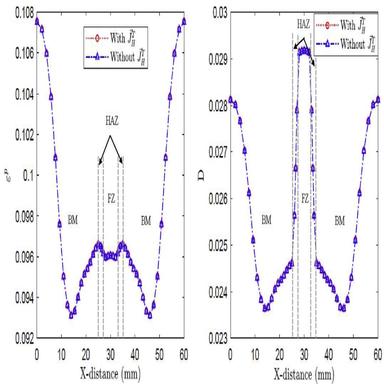
Equivalent plastic strain p (to the left) and damage variable D (to the right): comparison between the mechanical model and the M-D model.